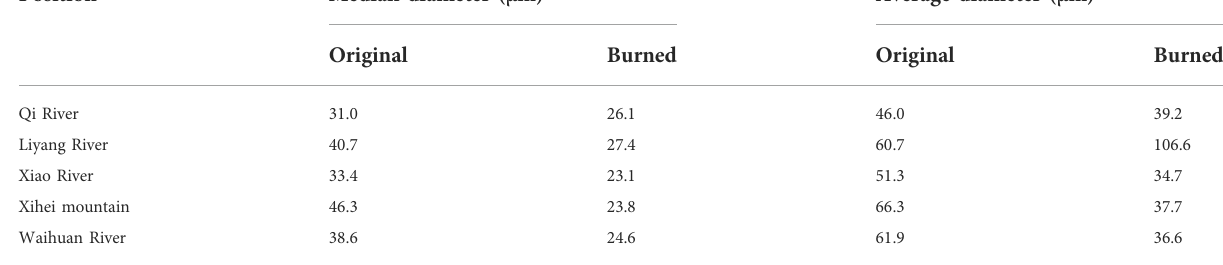
TABLE 1 Analysis of siltation particle